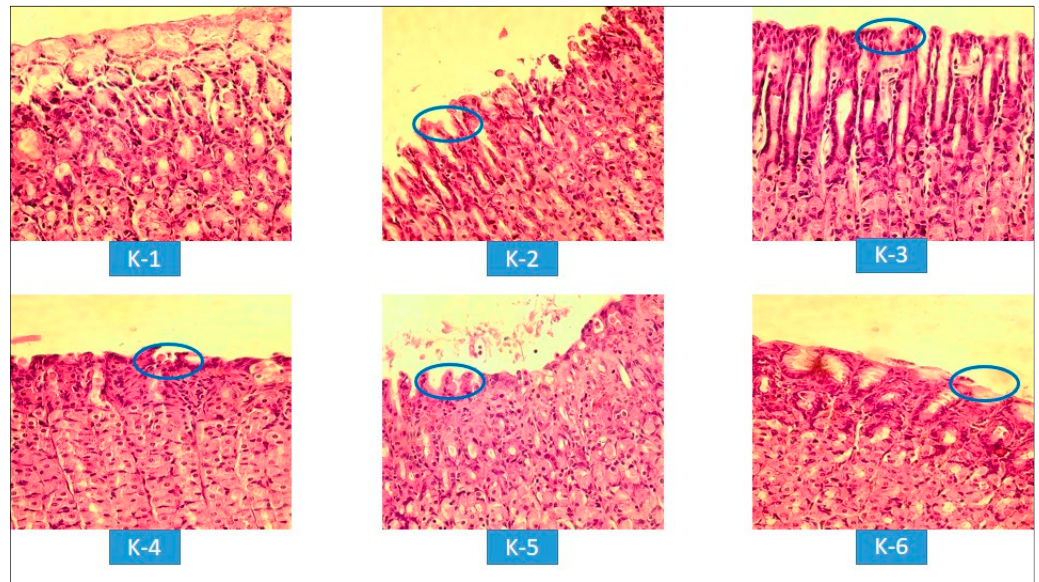
Figure 3. Microscopic result of epithelial erosion on mucosal layers of treatment group: K-1, Normal group; K-2, Negative control group (CMC); K-3, Positive control group (OMZ); K-4, Rice Bran Extract group 100 mg/kg BW; K-5, Rice Bran Extract group 200 mg/kg BW; and K-6, Rice Bran Extract group 400 mg/kg BW) (magnification 400 × ). = Epithelial erosion of mucosal layers.